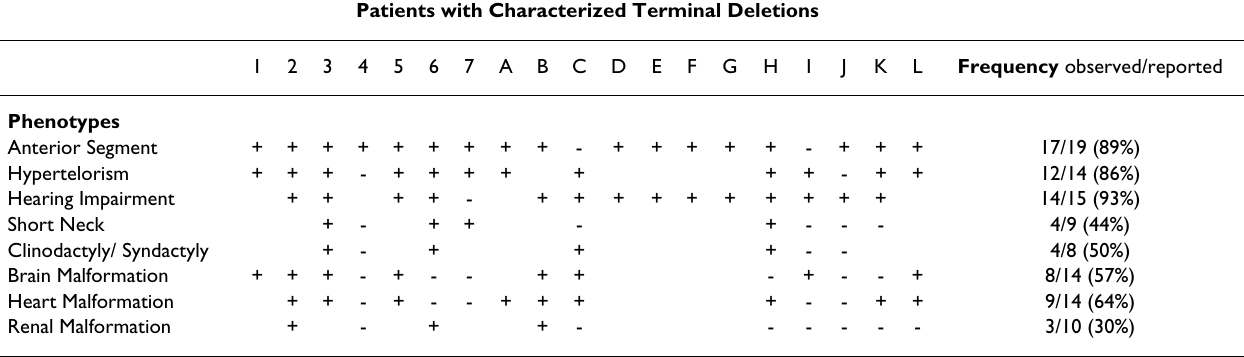
Table 2: Clinical features of patients with characterized terminal